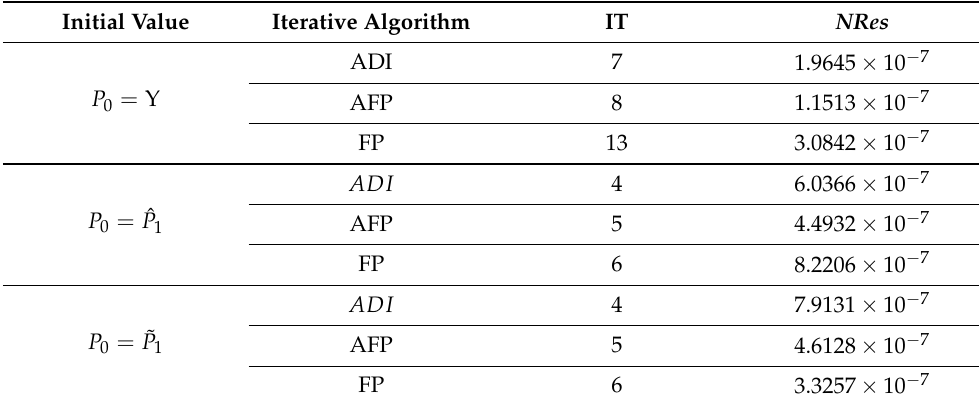
Table 1. The numerical results of FP, AFP and ADI when θ = 0.1.